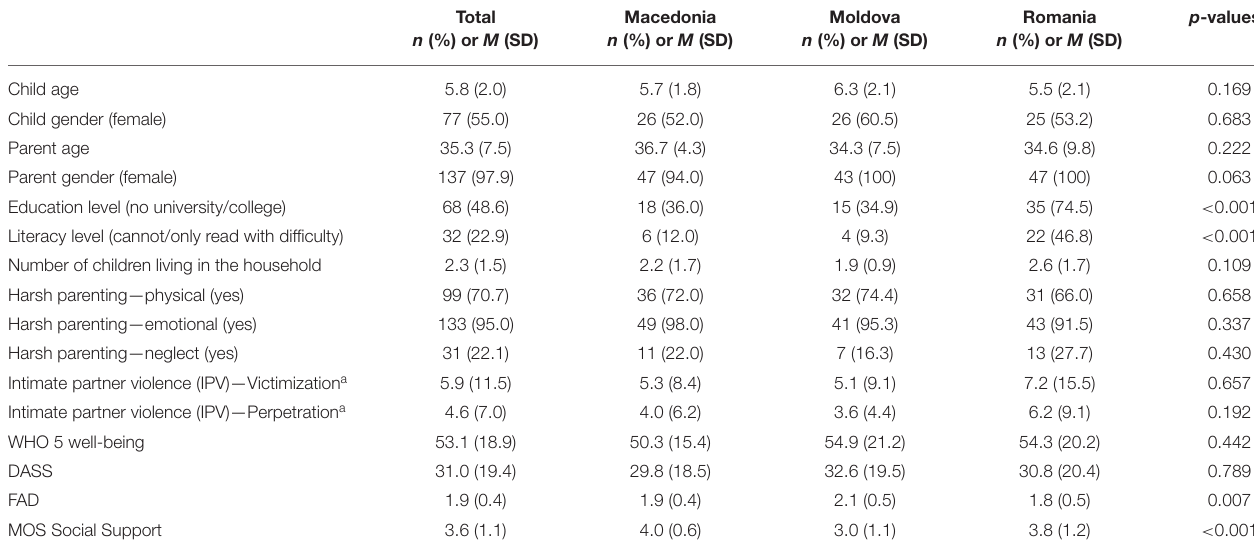
TABLE 1 | Sample characteristics for the total sample ( N = 140) and separated by country.